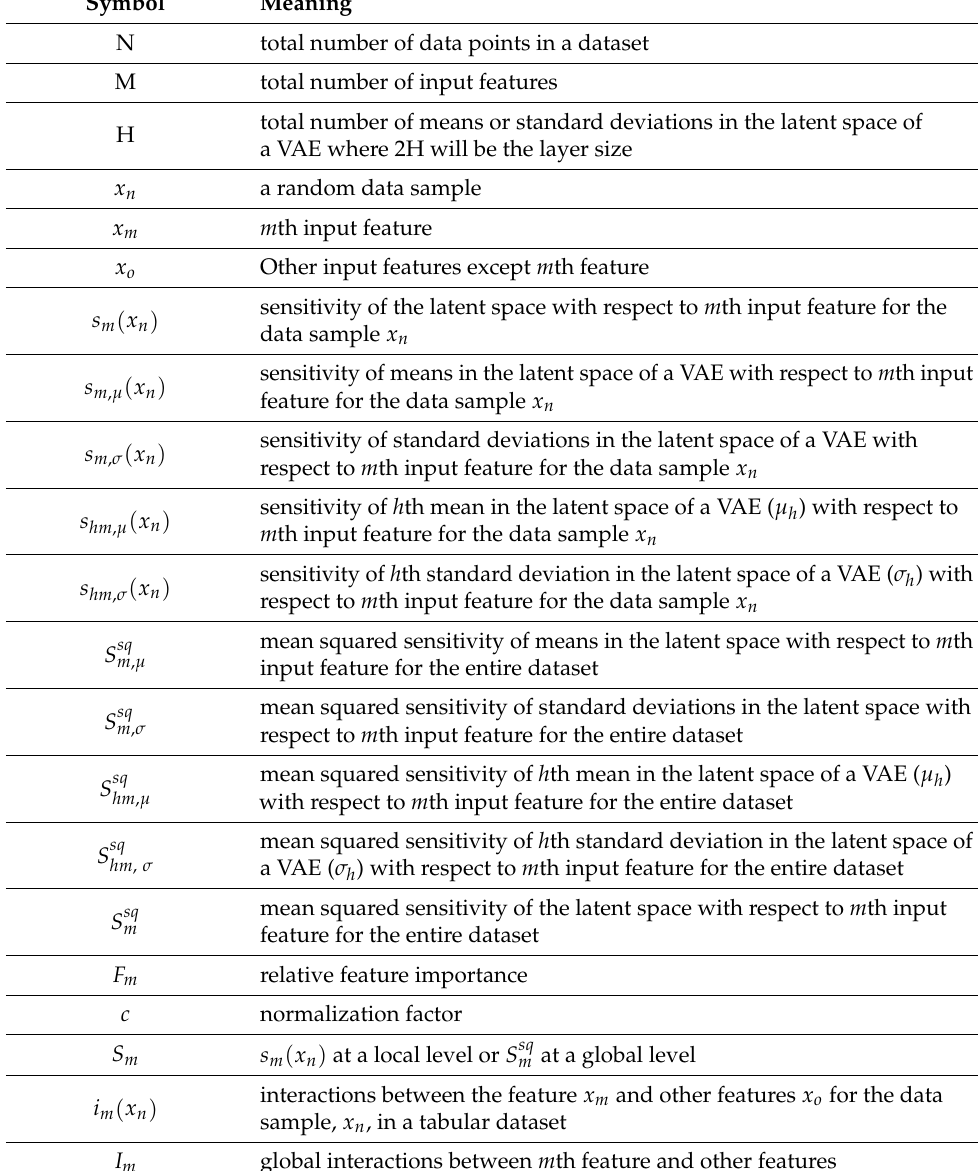
Table 1. Notations used in Section